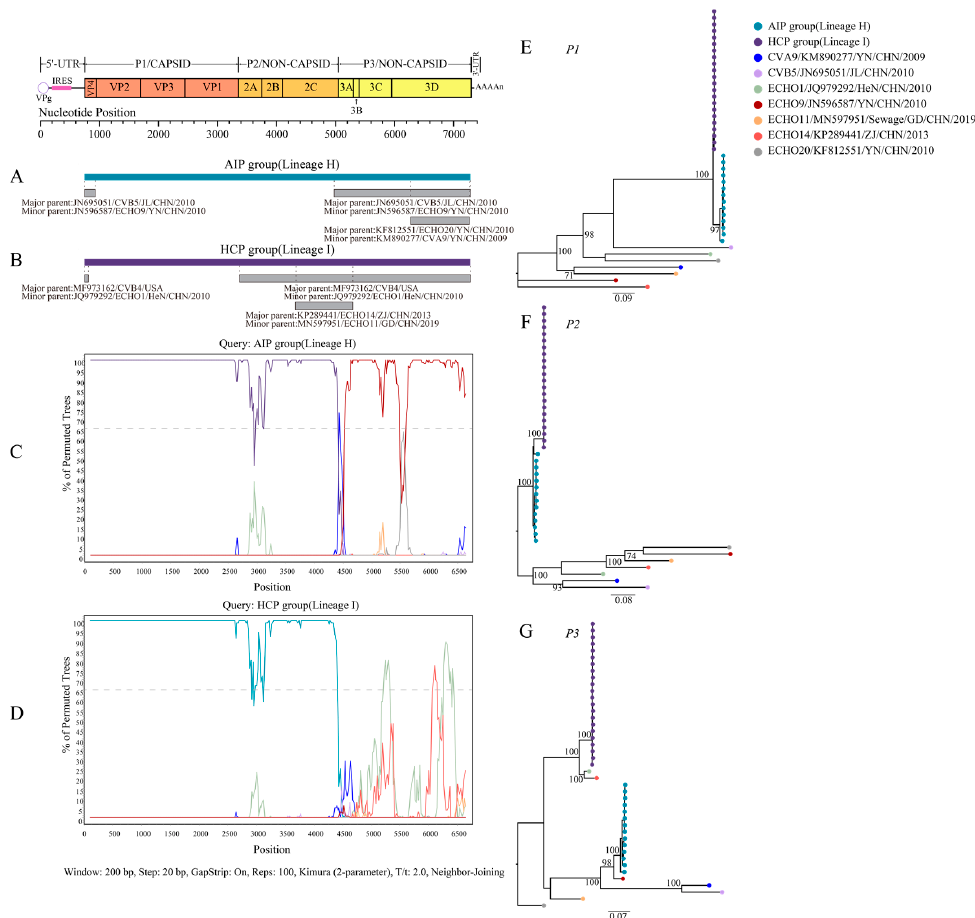
Figure 2. Recombination analysis of CVB4. Recombination analysis results based on sequences obtained after BLAST search are shown in Supplementary Figure S5. ( A ) Recombination analysis results of CVB4 isolated from the AIP group by RDP4. ( B ) Recombination analysis results of CVB4 isolated from HCP group by RDP4. ( C ) Recombination analysis results of CVB4 isolated from the AIP group by Simplot. Bootstrap values above 70% were considered to reflect the presence of recombination events (dashed positions). ( D ) Recombination analysis results of CVB4 isolated from the HCP group by Simplot. ( E – G ) ML trees constructed based on P1 , P2 , and P3 regions of the datasets consisting of CVB4 isolated from AIP and HCP groups, and their potential recombination sequences,